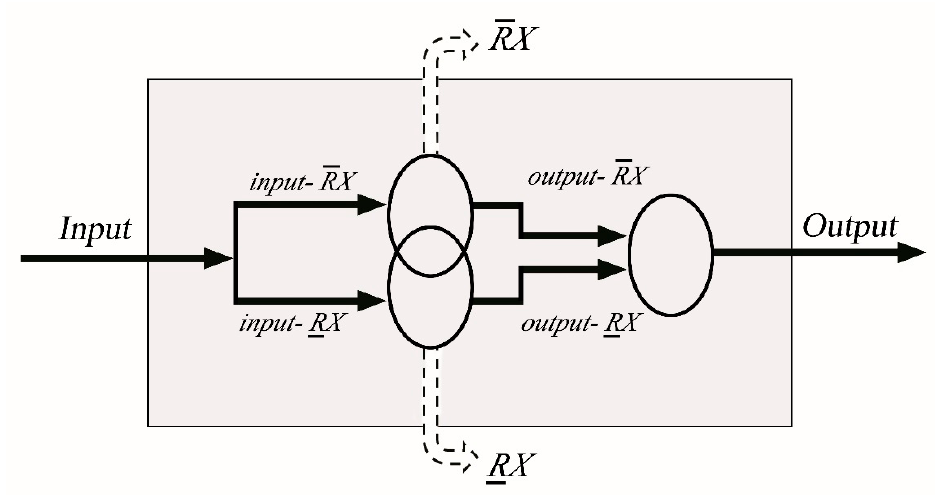
Figure 1. A schematic representation of RST.